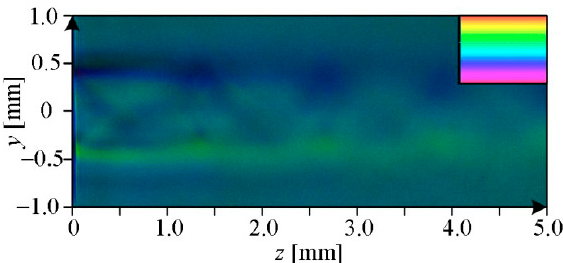
Figure 31. Rainbow Schlieren flow visualization. Reprinted with permission from Ref. [45] (2018).